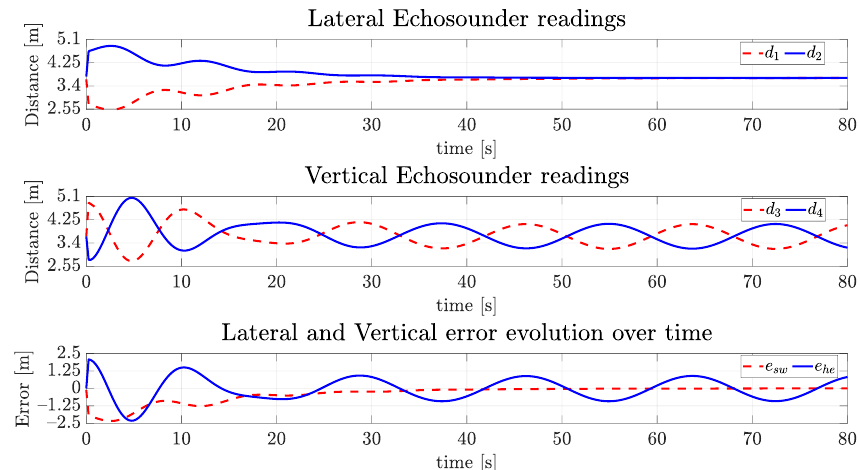
Figure 20. Readings of echosounders of the simulated vehicle and the vertical and horizontal errors over time for the sinusoidal path.